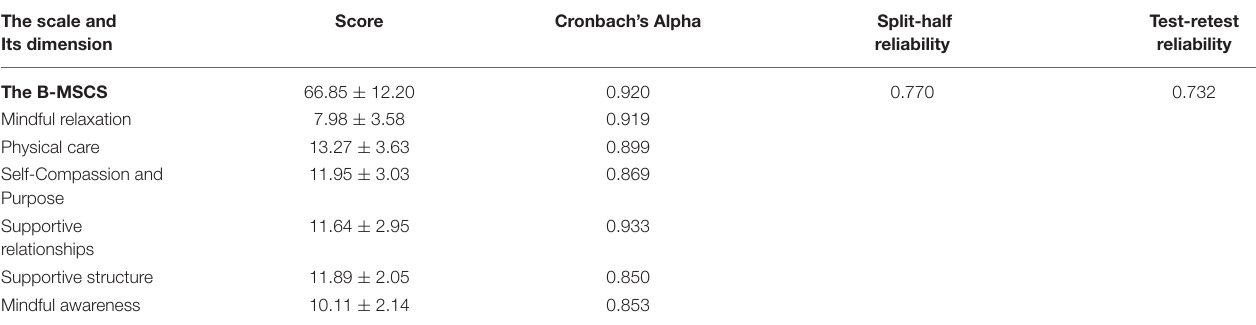
TABLE 3 | Reliability analysis for Chinese version of the B-MSCS.